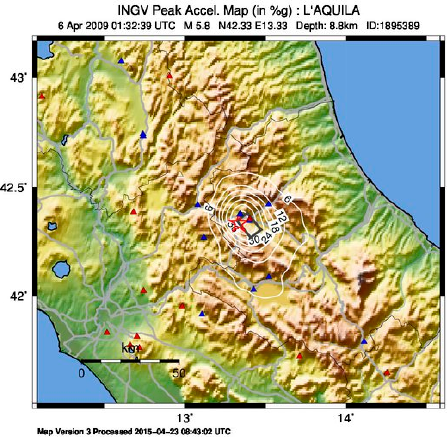
Figure 4. Shakemaps derived by the Italian National Institute of Geophysics and Volcanology (INGV) for PGA.